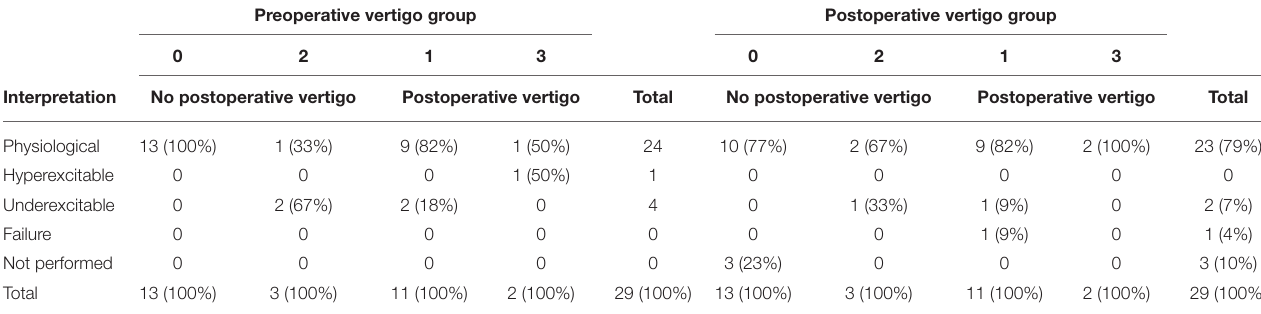
TABLE 7 | Result categories of caloric response test (pre- and post-operative) related to vertigo group (for information on vertigo group, see Table 2 ).